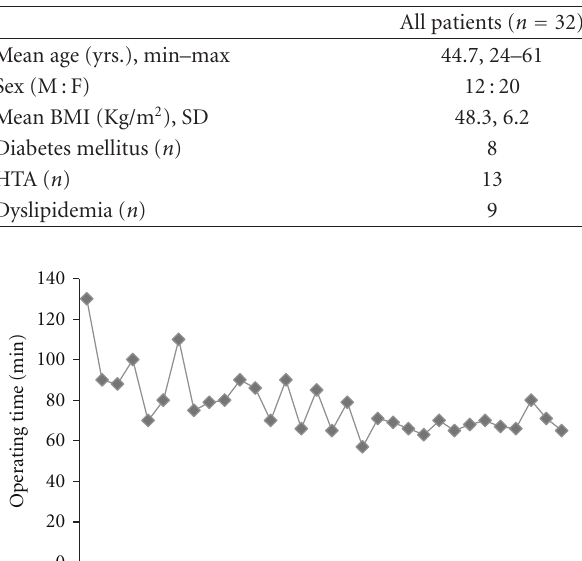
Table 1: Demographic data.